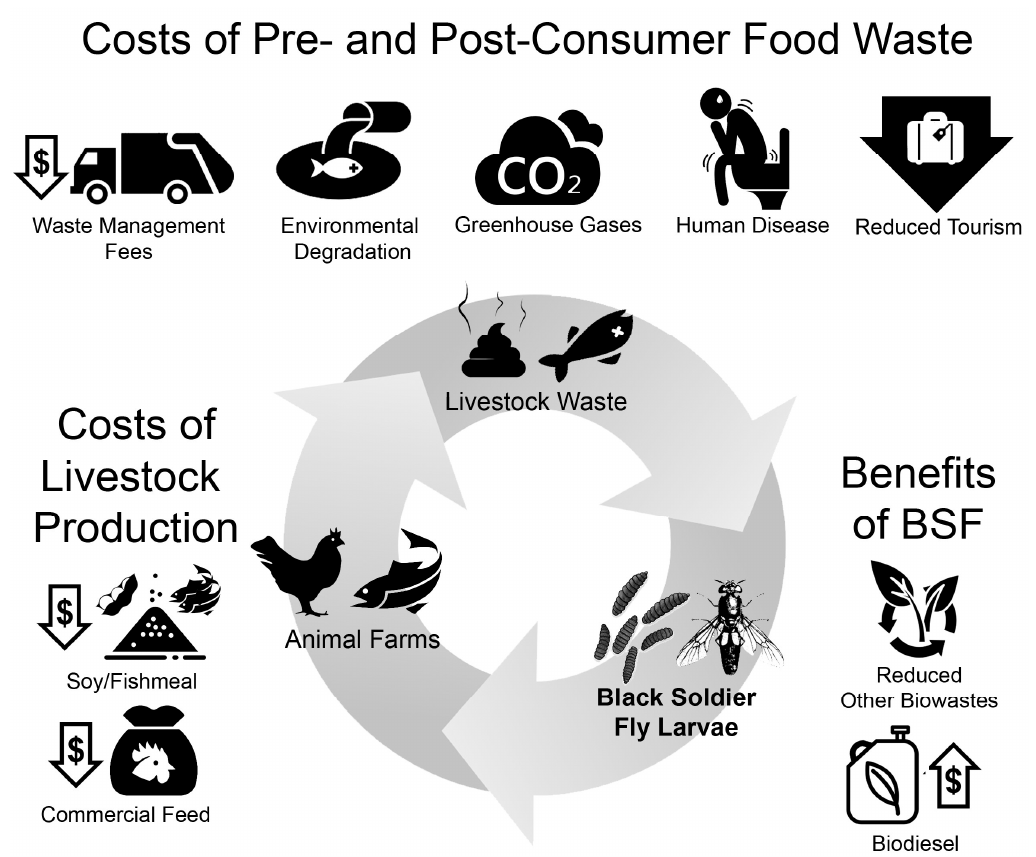
Figure 1. The closed-loop cycle of using black soldier flies (BSF) to process organic waste, including livestock waste itself, into livestock feed. Includes the costs of livestock production and livestock wastes, which would be reduced by BSF production, along with other benefits of BSF rearing.